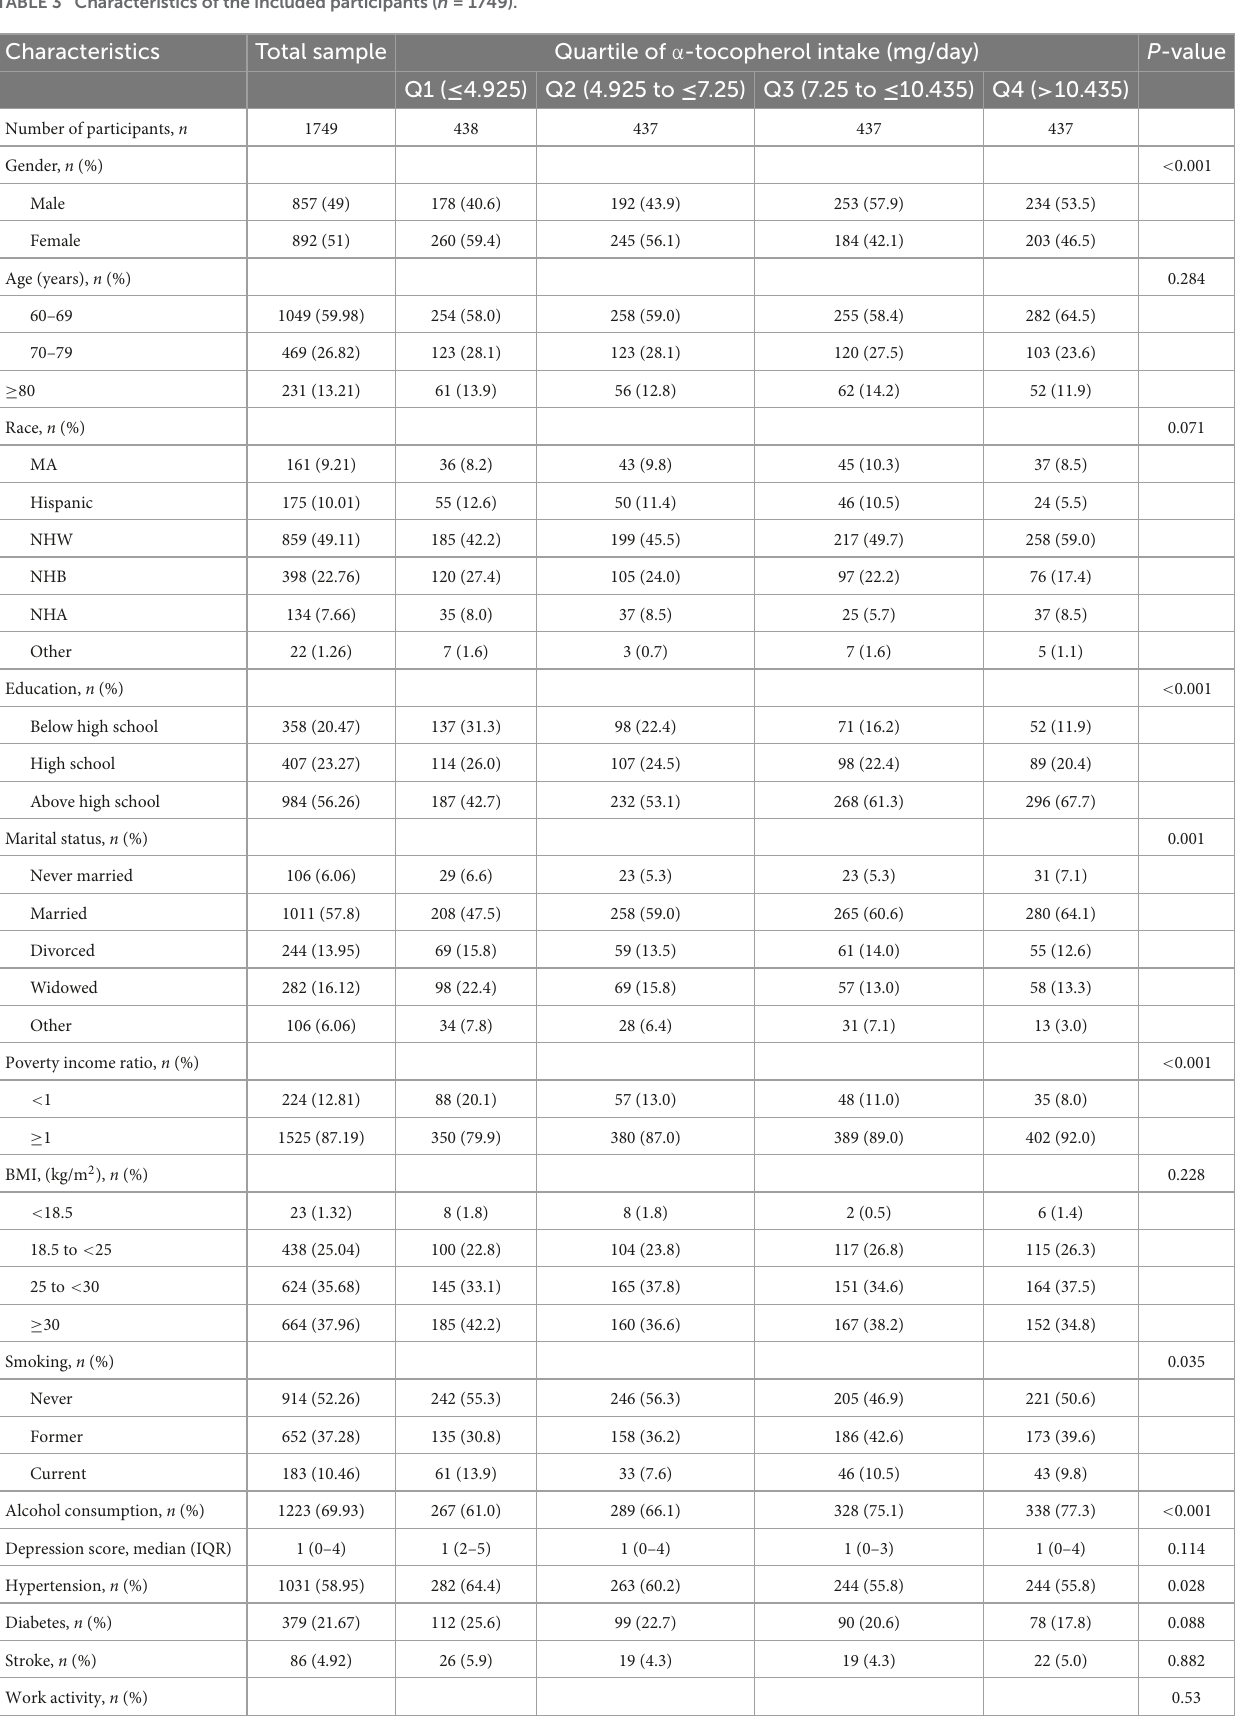
TABLE 3 Characteristics of the included participants ( n = 1749). Characteristics Total